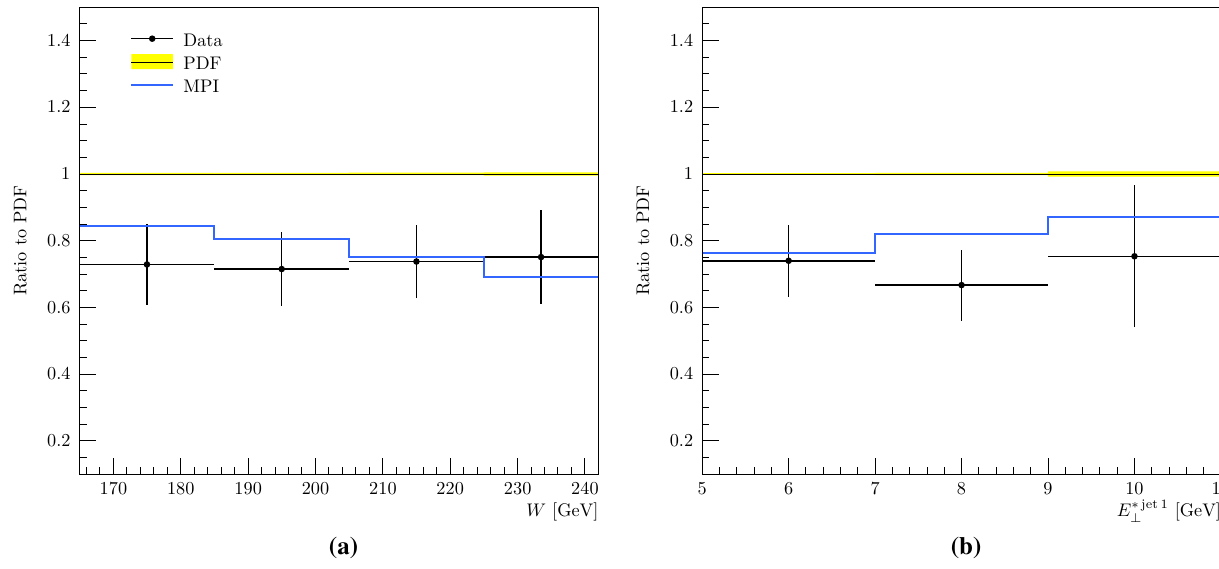
∗ jet1 ⊥ ( b ) compared to the H1